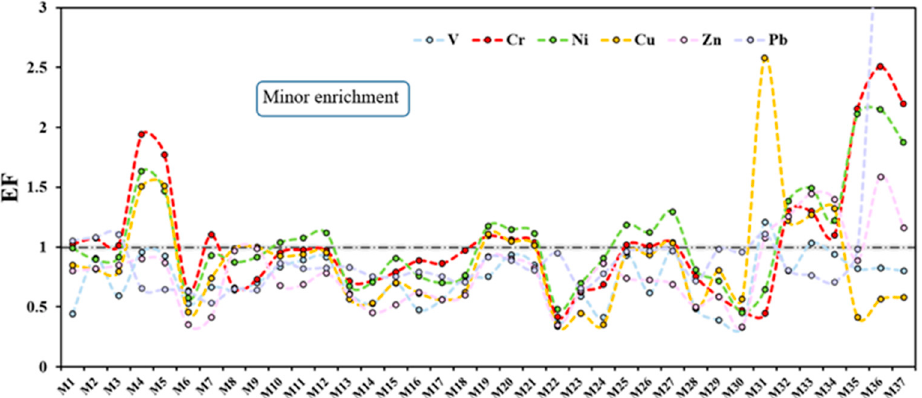
geo ) of selected metals in the soil.